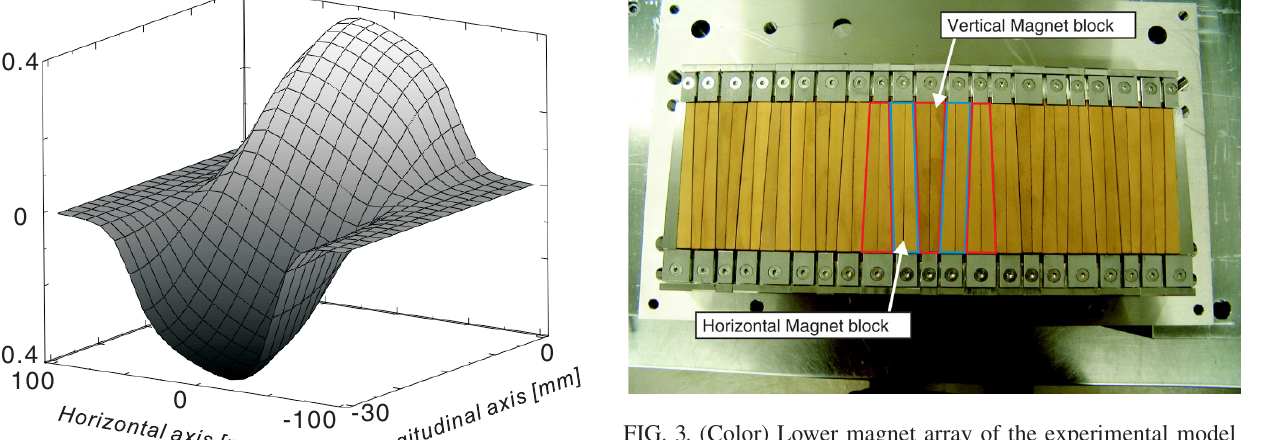
FIG. 3. (Color) Lower magnet array of the experimental model of the EF wiggler. The magnet blocks with vertical magnetiza- tion have a trapezoidal shape (rimmed with the red lines), while FIG. 2. Vertical magnetic field B of the EF wiggler with an those with longitudinal magnetization have a parallelogram y edge angle of 5 (cid:1) calculated for a half wiggler period. The period shape (with the blue lines). length is 60 mm and maximum field strength on the beam axis is 0.37 T at the magnet gap of 30 mm. A steep negative slope may be seen along the horizontal axis irrespective of the longitudinal